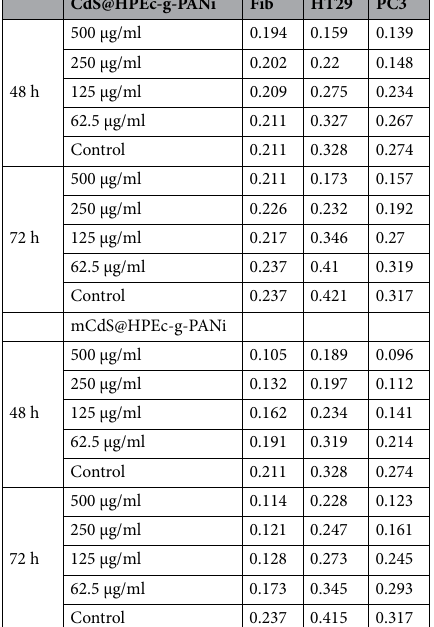
Table 2. The cytotoxicity results of the CdS@HPEc-g-PANi and mCdS@HPEc-g-PANi nanocomposites.